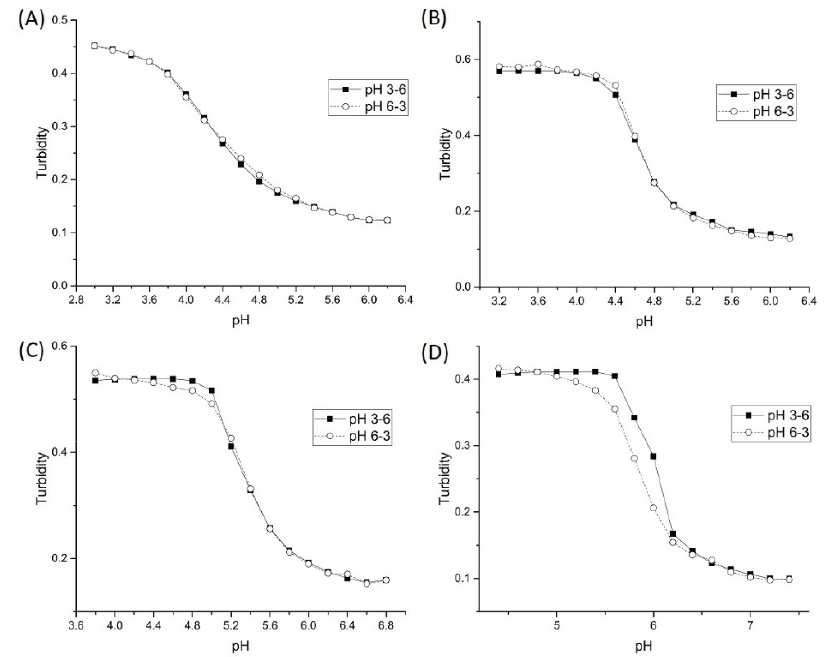
Figure 9. Forward and reverse ascending pH profiles of each polyNIPA synthate: ( A ) AA, ( B ) MAA, ( C ) EAA, and ( D ) PAA.